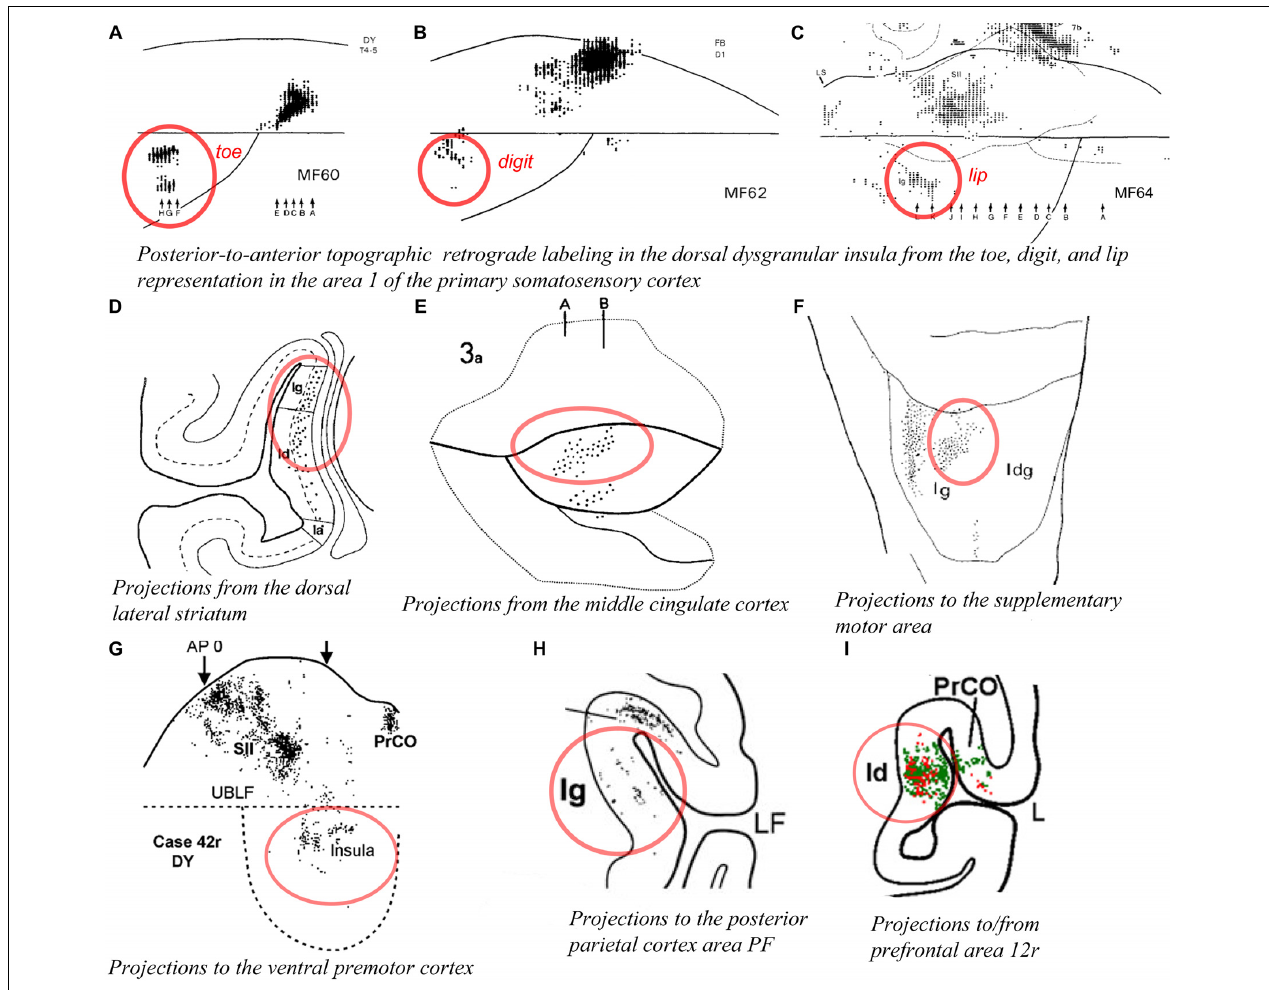
FIGURE 6 | Connectivity of the dorsal dysgranular area of the macaque insula. In all panels, the regions of labeling in the dorsal dysgranular region of the insula are denoted with a red circle. (A – C) Retrograde labeling produced in the posterior region of the dorsal part of the dysgranular insula with an injection of (A) diamidino yellow in the “toes 4–5,” (B) fast blue in the “digit 1,” and (C) diamidino yellow in “lower lip” representations in area 1 of the primary somatosensory cortex in cases MF60, MF62, and MF64, respectively (Burton et al., 1995). (D) Plot of retrograde labeling in a coronal section of the insula produced in case MS51 with an injection of WGA-HRP in the dorsal lateral portion of the corpus striatum. The authors considered as “granular” (Ig), a small region of the insula that was likely part of what we consider the dorsal dysgranular area (Chikama et al., 1997). (E) Flat map plot of anterograde labeling in the insula in case 3a with an injection of tritiated amino acid in the middle cingulate sulcus (Mesulam and Mufson, 1982b). (F) Flat map plot of retrograde labeling in the insula in case 3 with an injection of fast blue in the supplementary motor area (SMA or F3). The authors considered as “granular” (Ig) the region of the insula that we consider as the dorsal dysgranular area (Luppino et al., 1993). (G) Flat map plot of retrograde labeling in the insula in case 42r with an injection of diamidino yellow in the ventral premotor cortex (PMv or F5) (Gerbella et al., 2011). (H) Coronal plot of retrograde labeling in the insula in case 29 with an injection of diamidino yellow in the area PF of the posterior parietal cortex. The authors considered as “granular” (Ig) the region of the insula that we consider as the dorsal dysgranular area (Rozzi et al., 2006). (I) Coronal plot of retrograde (red) and anterograde (green) labeling in the insula in case 44r with an injection of lucifer yellow in the area 12r of the prefrontal cortex (Borra et al., 2011). All illustrations in the panels of this figure were adapted with permission from the publishers of the cited